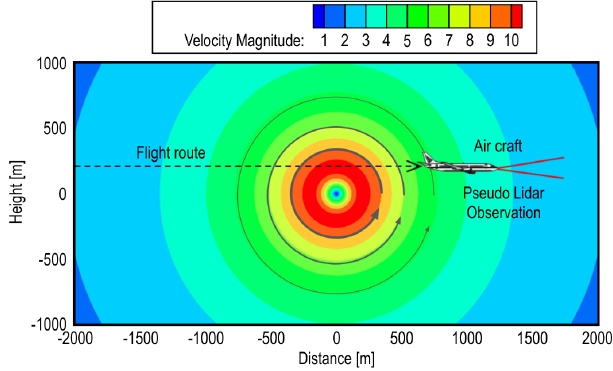
Figure 8. The distribution of vertical wind velocity generated by the Burnham–Hallock vortex